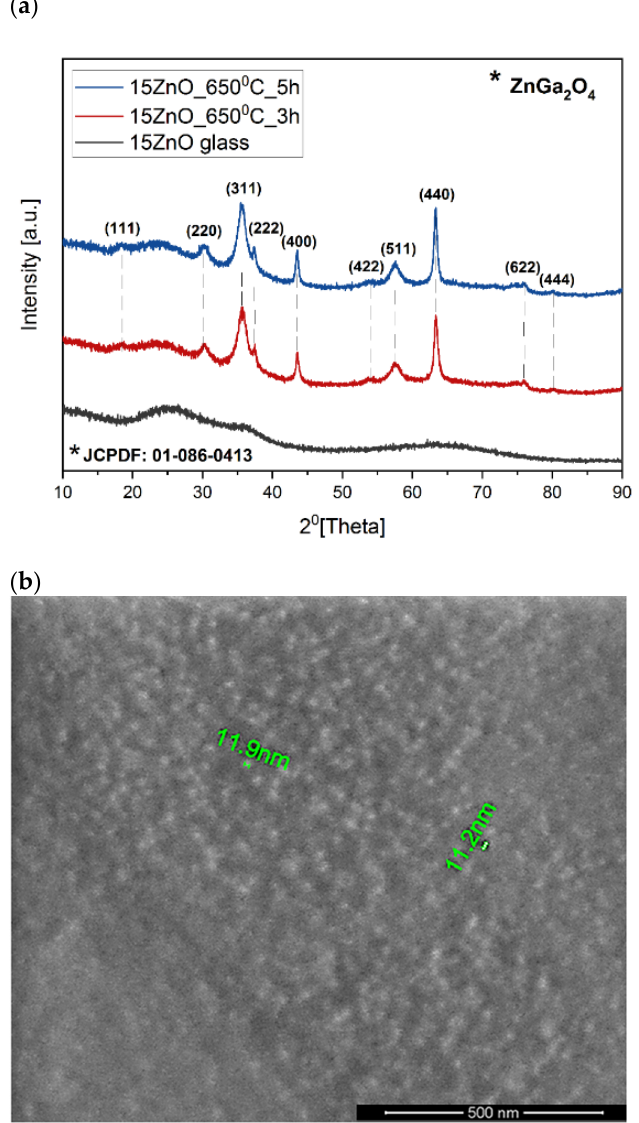
Figure 5. ( a ) Diffraction patterns of the samples doped with nickel and erbium ions doped with 0.1NiO, ( b ) SEM image of the GGK with 15ZnO co-doped with 0.1NiO/0.1Er 2 O 3 glass-ceramics (HT@650 °C for 1–5 h) with indicated ZnGa 2 O 4 nanocrystals. Table 3. Crystallography data for co-doped 15ZnO_650 ◦ C_3 h